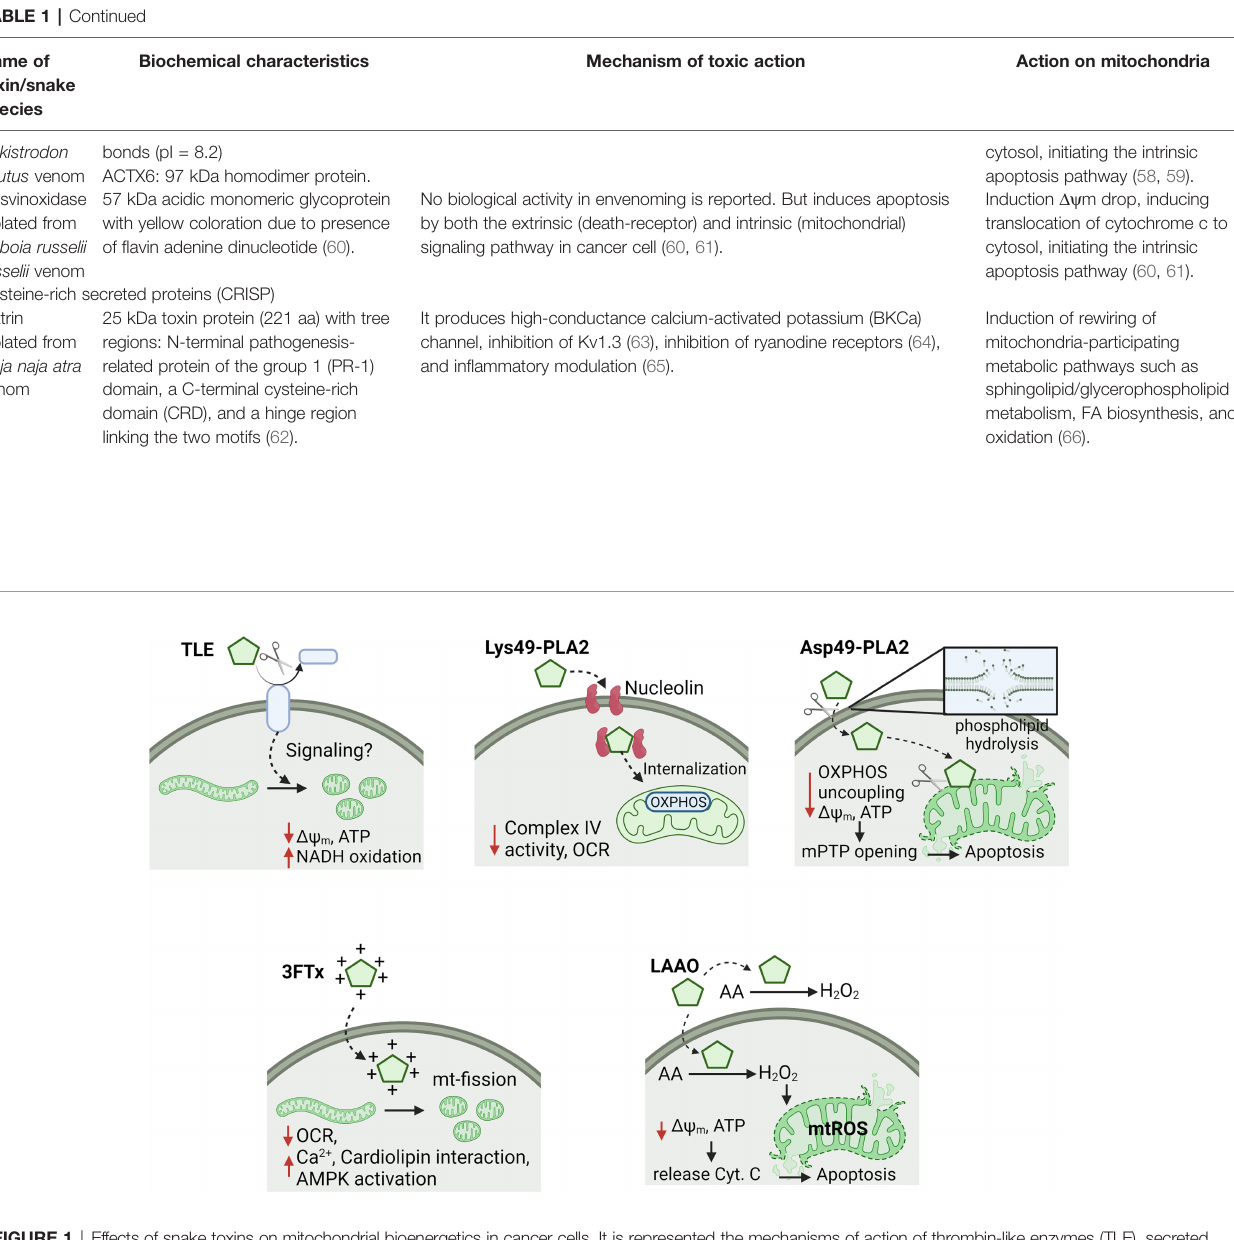
FIGURE 1 | Effects of snake toxins on mitochondrial bioenergetics in cancer cells. It is represented the mechanisms of action of thrombin-like enzymes (TLE), secreted Lys49- and Asp49-phospholipases A2 (PLA2), three- fi nger toxins (3FTx) and L-amino acid oxidases (LAAO). Some toxins affect the oxidative phosphorylation (OXPHOS) by uncoupling or Complex IV inhibition, which decreases the mitochondrial membrane potential ( Dy m ) and ATP levels. Moreover, other toxins produce mitochondrial fragmentation (e.g. TLE and 3FTx) or permeabilization of inner mitochondrial membrane (e.g. Asp49-PLA2 and LAAO), triggering apoptosis. Cysteine-rich secreted proteins, and snake C-type lectin toxins were excluded of this fi gure due to reduced information of a putative mechanism of action on mitochondria. OCR, oxygen consumption rate; Cyt. C, cytochrome C; mPTP, mitochondrial permeability transition pore; mtROS, mitochondrial ROS; AA, amino acids; mt- fi ssion, mitochondrial fi